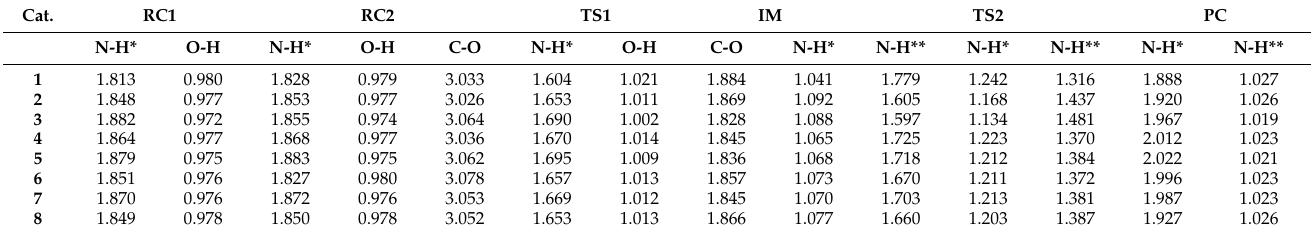
Table 4. The N-H, O-H, and C-O bond lengths (Å) along the phenyl isocyanate (PhNCO) and methanol reaction pathway in the presence of the studied catalysts. N-H* for catalysts, while N-H** for